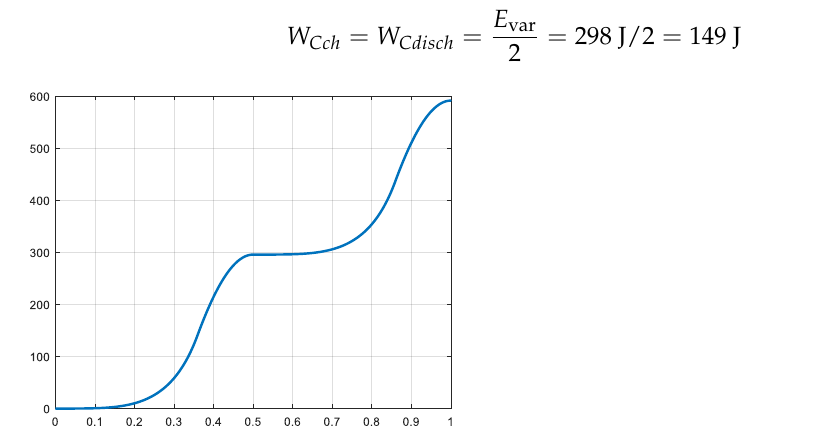
Figure 22. Energy flow from the motor to the compression cylinders (J). During one cycle of the power which corresponds to one half of the revolution of the crankshaft, the energy variation is of 298 J. During this variation, the storage capacitor is charged and discharged to obtain a smooth average value at the level of the power ex- change with the grid. The amounts of charged energy and of the discharged one are iden- tic, and are equal to the half of the energy variation mentioned before.